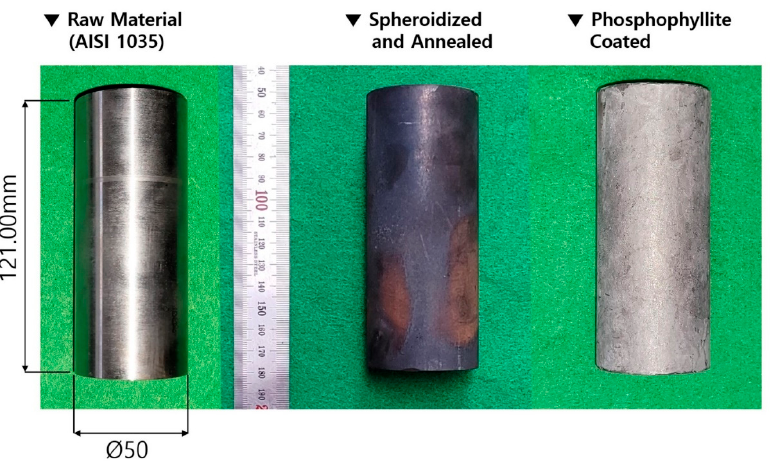
Figure 13. Initial workpiece, spheroidizing-annealing heat-treated specimen, and phosphophyllite- coated initial billet.